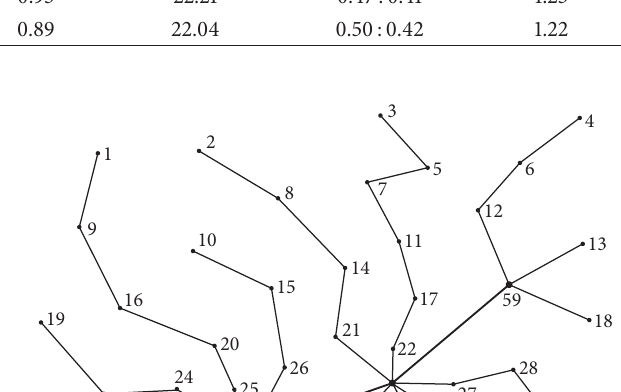
Figure 2: Convergence efficiency of GA under M-to-1.